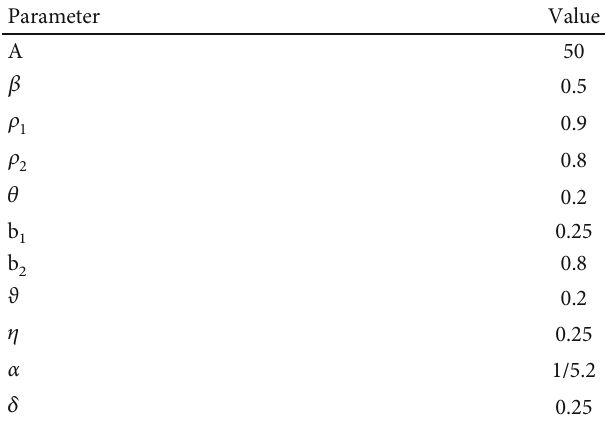
Table 1: Parameter value used in simulation of models (2) and